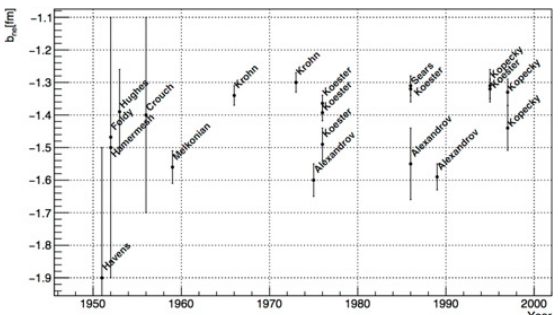
Figure 5. Measurements of b ne over time. Data points taken from [18] and include data from transmission, diffraction, reflectometry, and scattering experiments.